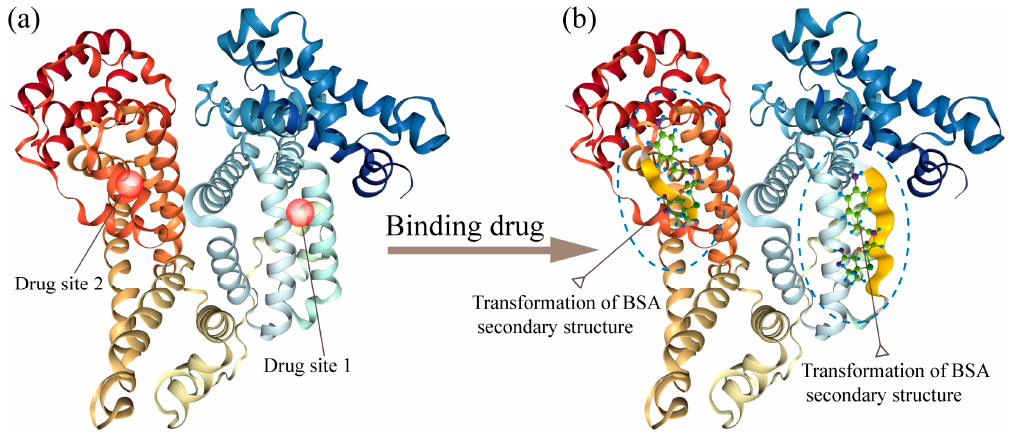
Figure 1. ( a ) The crystal structure of bovine serum albumin (BSA) (PDB ID: 3V03). ( b ) Schematic illustration of the structure and conformational variation of BSA in complex with a drug.